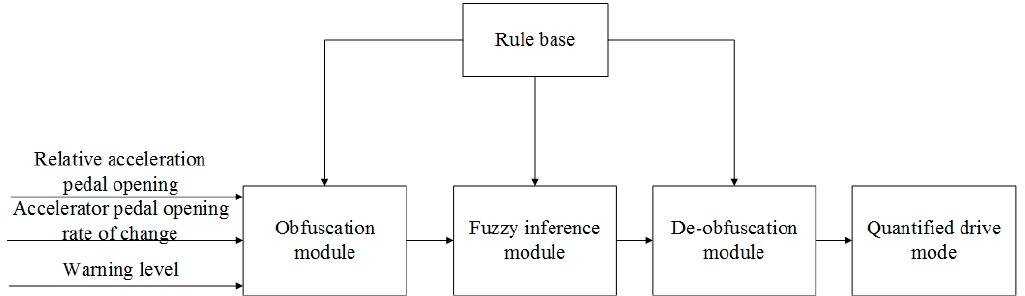
Figure 8. Function of warning level model.